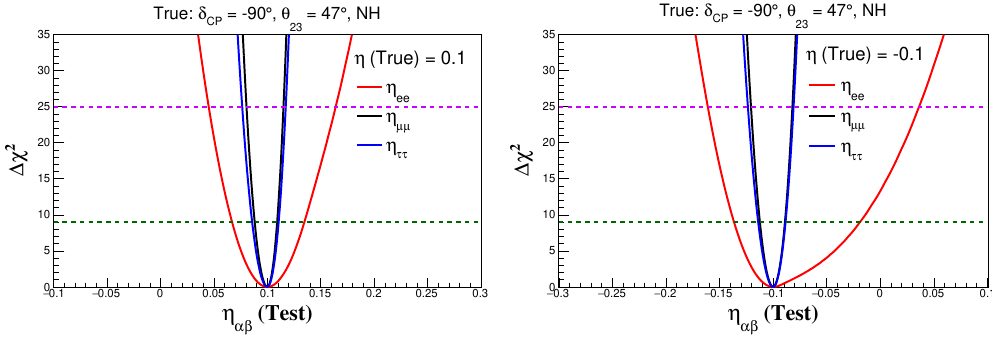
Figure 5 . The sensitivity of DUNE to true η αβ = 0 . 1 (left panel) and true η αβ = -0.1 (right panel) at true δ CP = − π /2 and true θ 23 = 47 ◦ . In both of the plots, the red-solid curve is for η ee , the black-solid curve is for η µµ , and the blue-solid curve is for η ττ